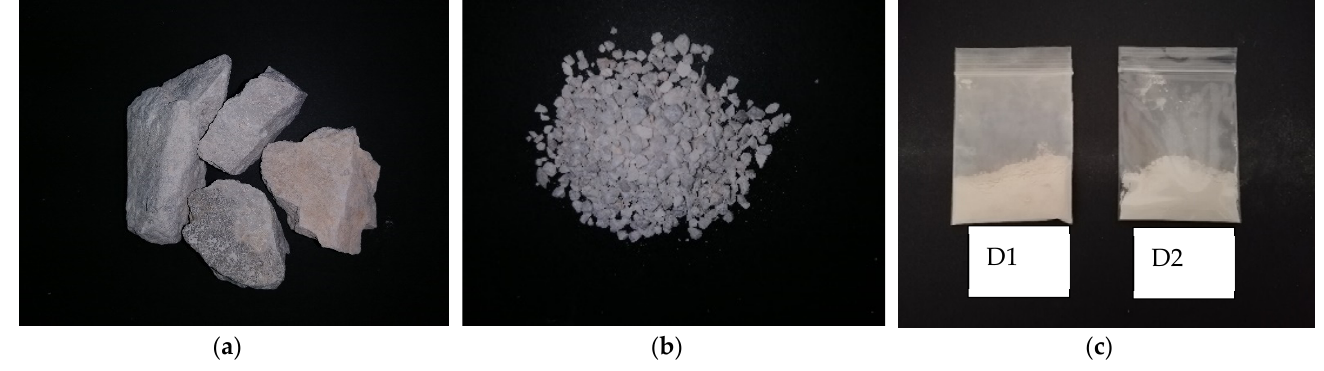
Figure 5. ( a ) Dolomite in gravel form, ( b ) dolomite in smaller granule form, and ( c ) dolomite in fine powder form. Table 1. The physical properties of dolomite and calcite.